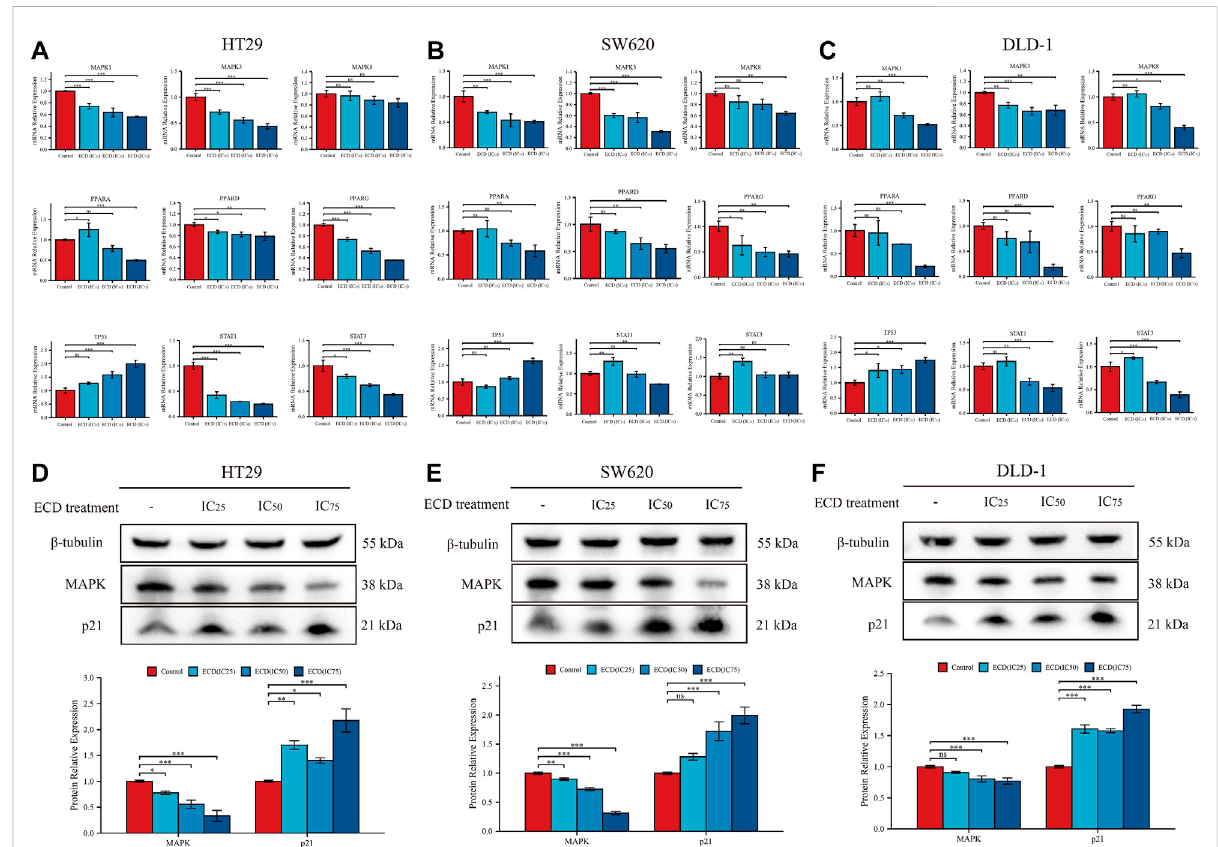
FIGURE 10 Underlying molecularmechanismsofECD inCRC treatments. (A – C) The mRNA relativeexpressionlevels ofMAPKs, PPARs, STATs, and TP53 in HT29 (A) , SW620 (B) , and DLD-1 (C) cell lines treated with different working concentrations (IC 25 , IC 50 , and IC 75 ) of ECD for 48 h measured by real- time PCR ( n = 3 per group). D-F. The protein relative expression of MAPK and p21 in HT29 (D) , SW620 (E) , and DLD-1 (F) cell lines treated with different working concentrations (IC 25 , IC 50 , and IC 75 ) of ECD for 48 h measured by western blot ( n = 3 per group). ns P > 0.05, * p < 0.05, ** p < 0.01, *** p <